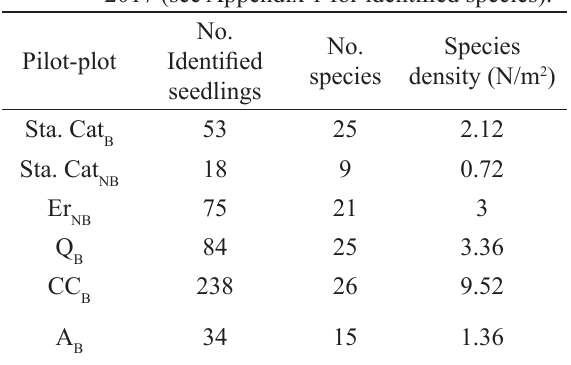
Table 4. Number of seedlings and species identified per pilot-plot in the greenhouse experiment. Data correspond to the seed bank samples from 2017 (see Appendix 1 for identified